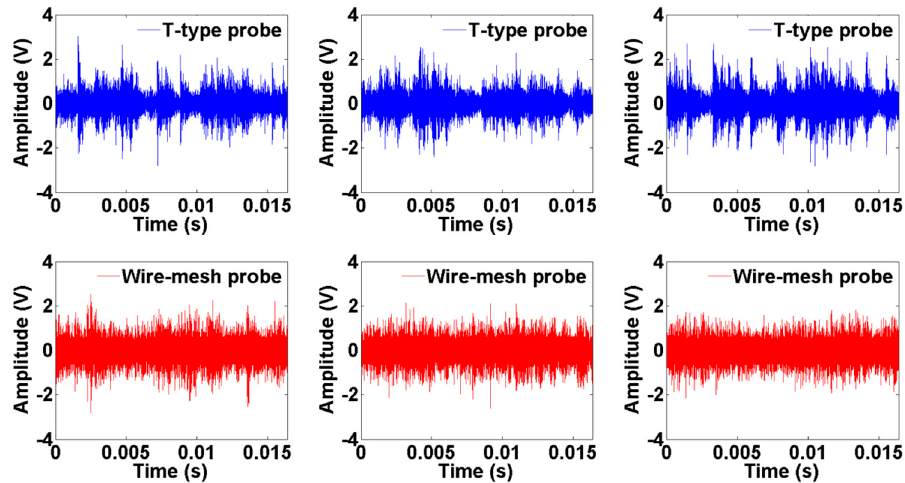
Figure 7. ( a ) The root mean square (RMS) distribution and ( b ) the relative error for each probe type. Figure 8. The RMS average values of the AE signals with respect to particle mass flow rate at four different particle sizes.